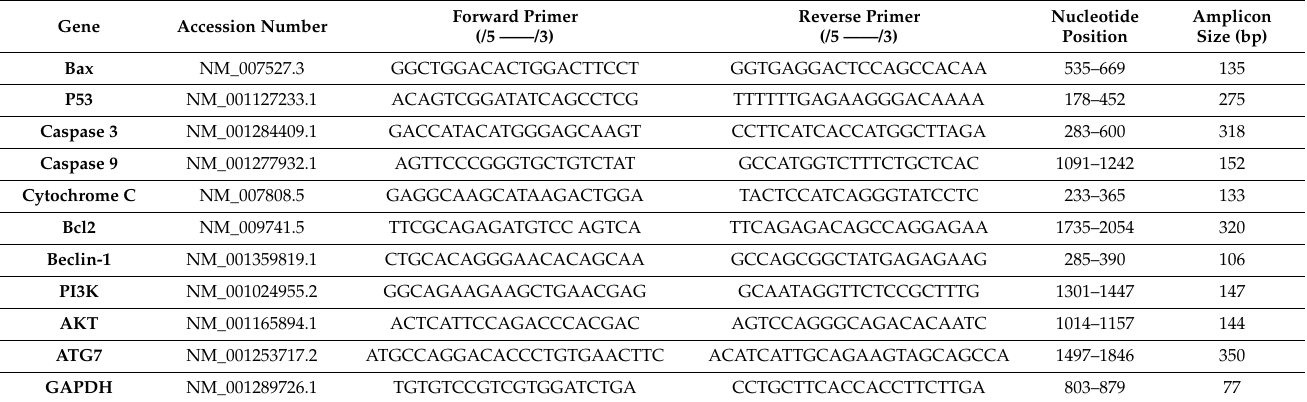
Table 5. Mouse primer sequences used in real-time